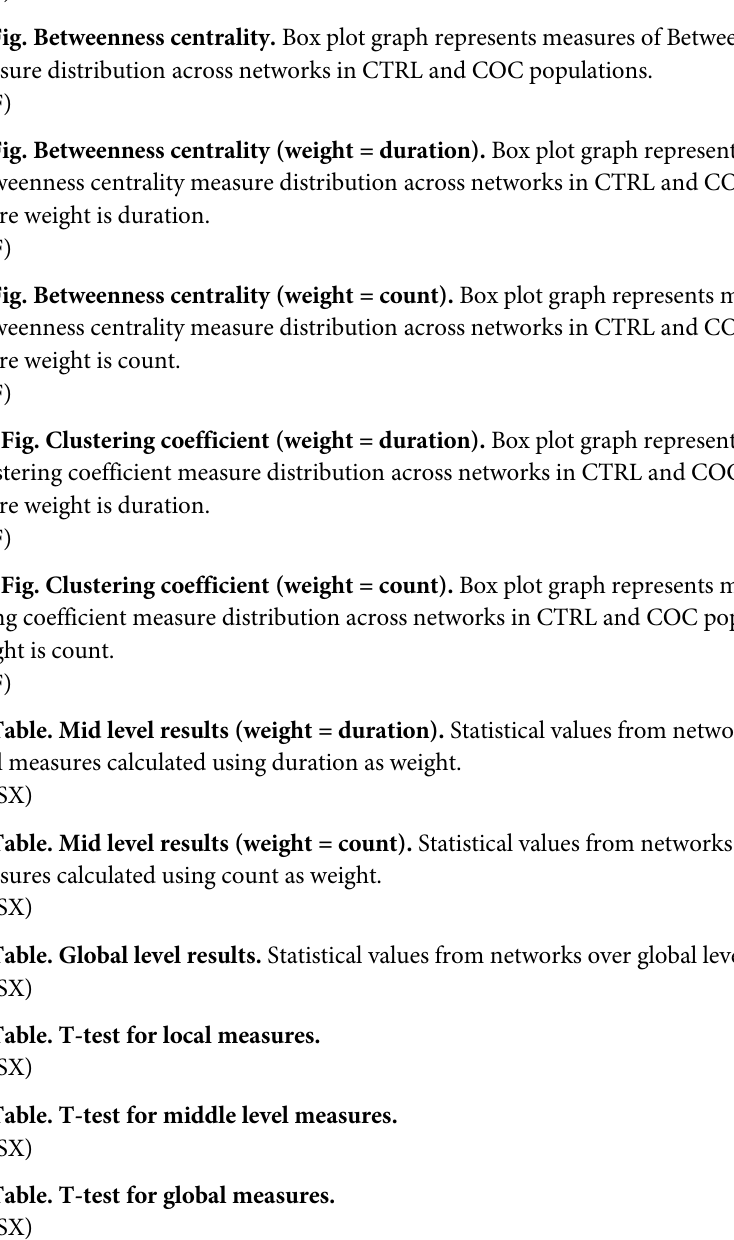
S6 Fig. Strength (weight = count). Box plot graph represents measures of Strength measure distribution across networks in CTRL and COC populations, where weight is count. S7 Fig. Betweenness centrality. Box plot graph represents measures of Betweenness centrality measure distribution across networks in CTRL and COC populations. S8 Fig. Betweenness centrality (weight = duration). Box plot graph represents measures of Betweenness centrality measure distribution across networks in CTRL and COC populations, where weight is duration. S9 Fig. Betweenness centrality (weight = count). Box plot graph represents measures of Betweenness centrality measure distribution across networks in CTRL and COC populations, where weight is count. S10 Fig. Clustering coefficient (weight = duration). Box plot graph represents measures of Clustering coefficient measure distribution across networks in CTRL and COC populations, where weight is duration. S11 Fig. Clustering coefficient (weight = count). Box plot graph represents measures of Clus- tering coefficient measure distribution across networks in CTRL and COC populations, where weight is count. S1 Table. Mid level results (weight = duration). Statistical values from networks over mid- level measures calculated using duration as weight. S2 Table. Mid level results (weight = count). Statistical values from networks over mid-level measures calculated using count as weight. S3 Table. Global level results. Statistical values from networks over global level measures. S4 Table. T-test for local measures. S5 Table. T-test for middle level measures. S6 Table. T-test for global